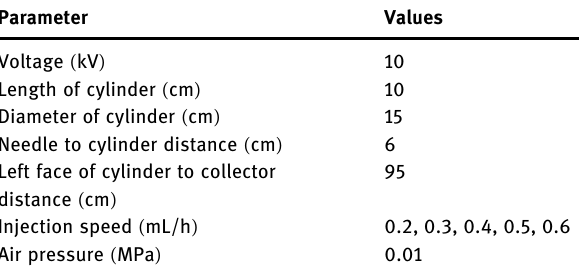
Table 2: Spinning conditions of di ff erent injection speeds